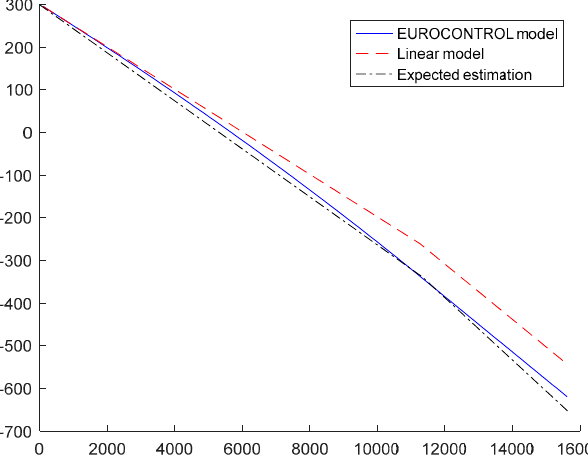
Figure 11. Representation of altitude bias for EUROCONTROL model, linearized model and expected estimation for ∆ H p = 300 m and ∆ T = 15 ◦